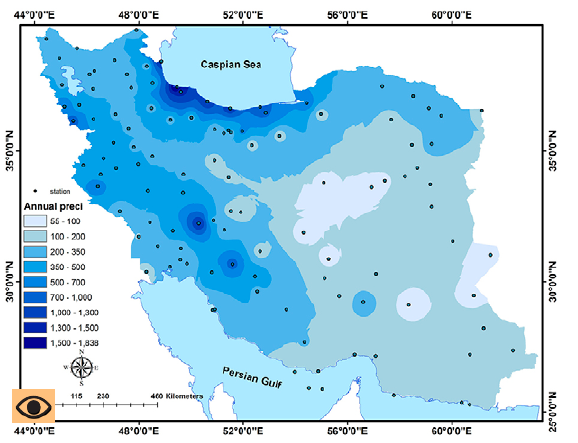
Figure 3. CV of annual precipitation across Iran over the period